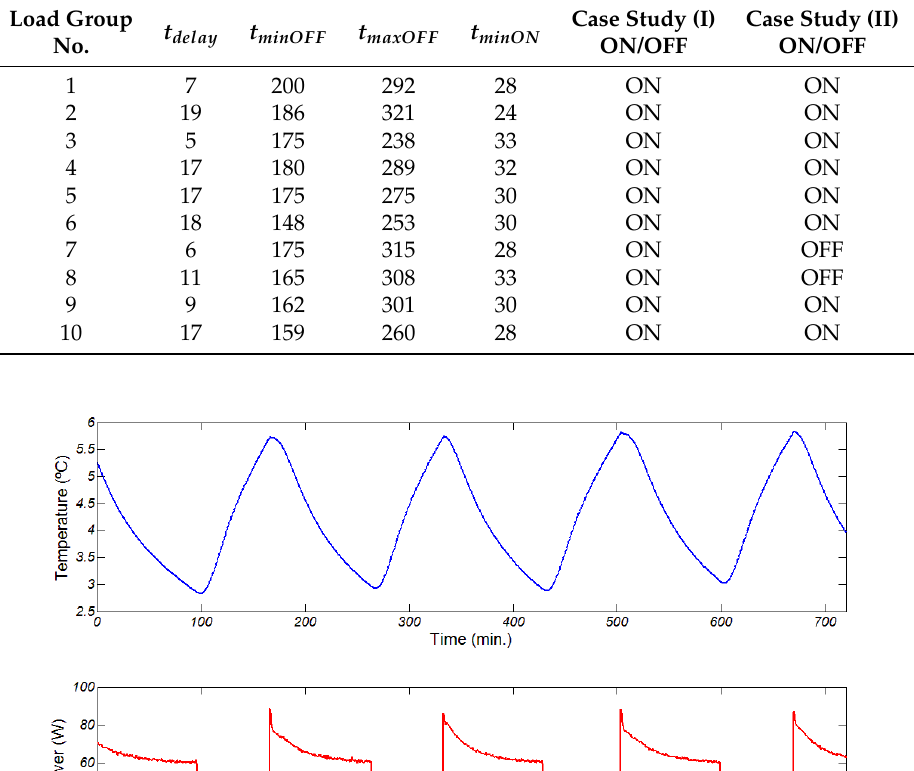
Table 1. Fridges/freezers’ operating characteristics.